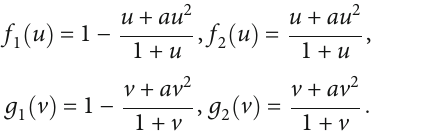
= 0 : 01993 of the variational parameter t shown for the polynomial function Q ð t Þ = 8525 : 16 t 2 − Figure 4: The minimum value t min 1 339 : 75 t + 125 : 15 (equation (11)) for the fi rst-order variation in hump-like